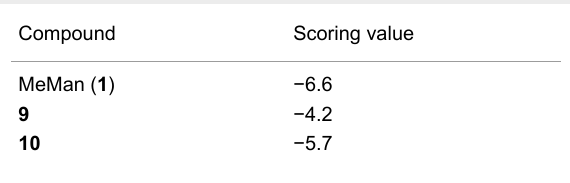
Table 1: Docking scoring values of the most stable conformers complexed by FimH (open gate structure PDB 1KLF) of MeMan ( 1 ) in comparison with Amadori rearrangement